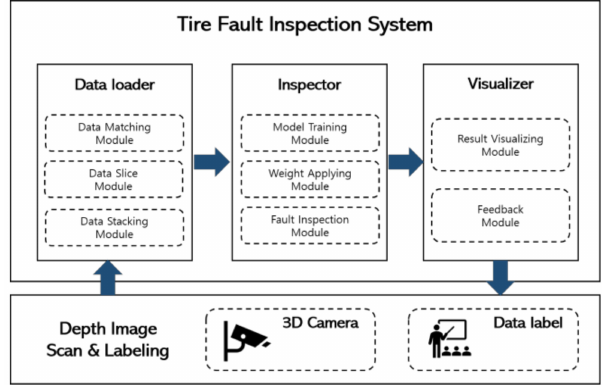
Figure 10. The tire fault inspection